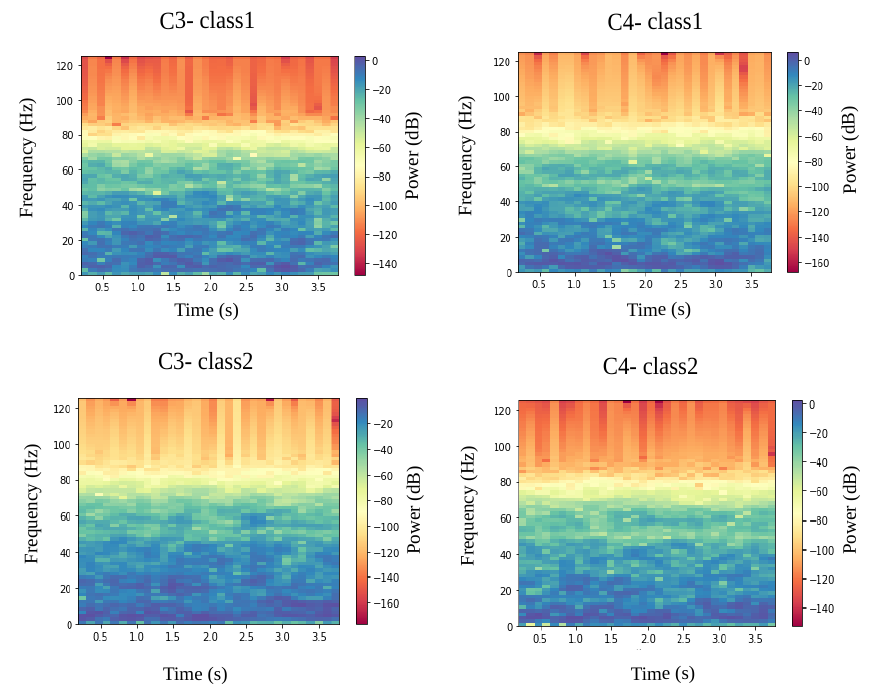
Figure 2. Example of the generated spectrograms from C3 and C4 electrode during left (class 1) and right (class 2) hand movements